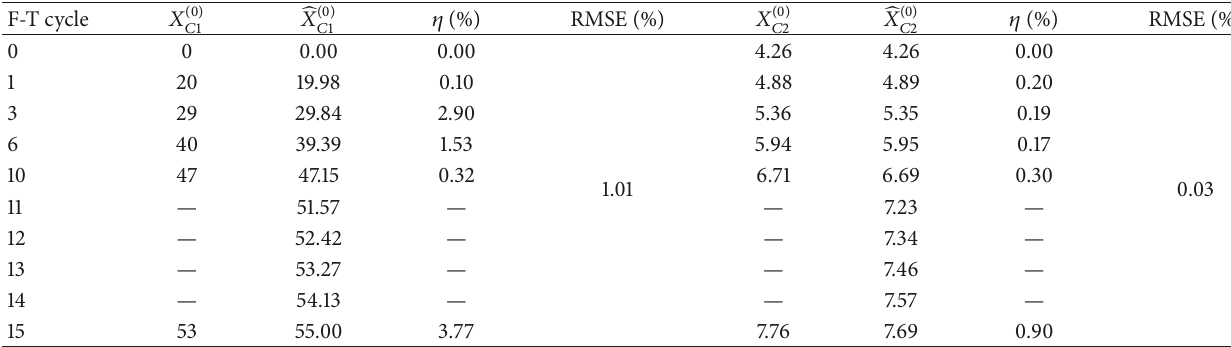
Table 13: Prediction results of 𝑋 (0) 𝐶1 and 𝑋 (0) 𝐶2 for CRSMA based on MGM (1,